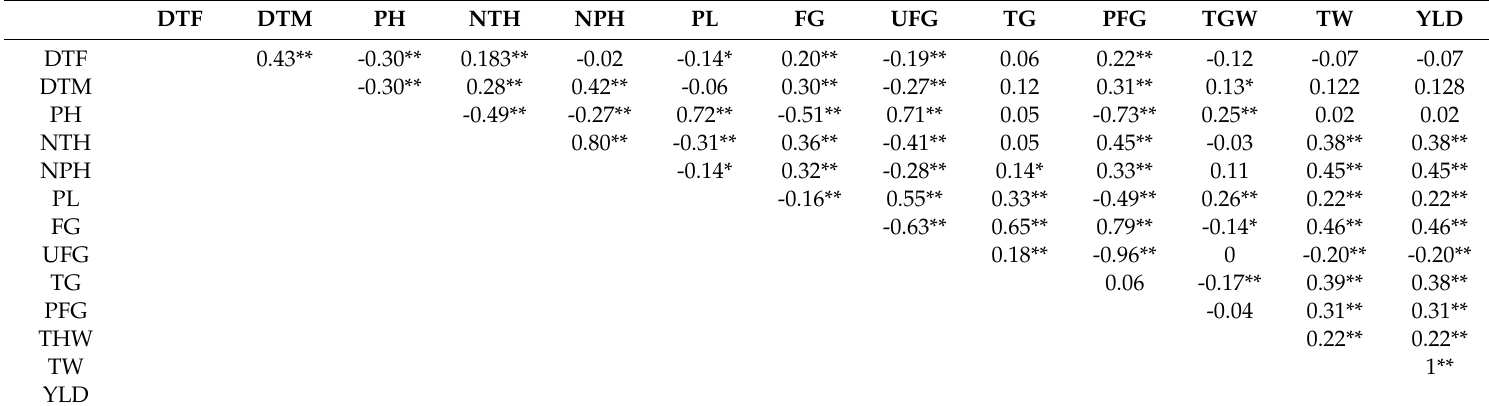
Table 5. Correlation coe ffi cients among the quantitative traits